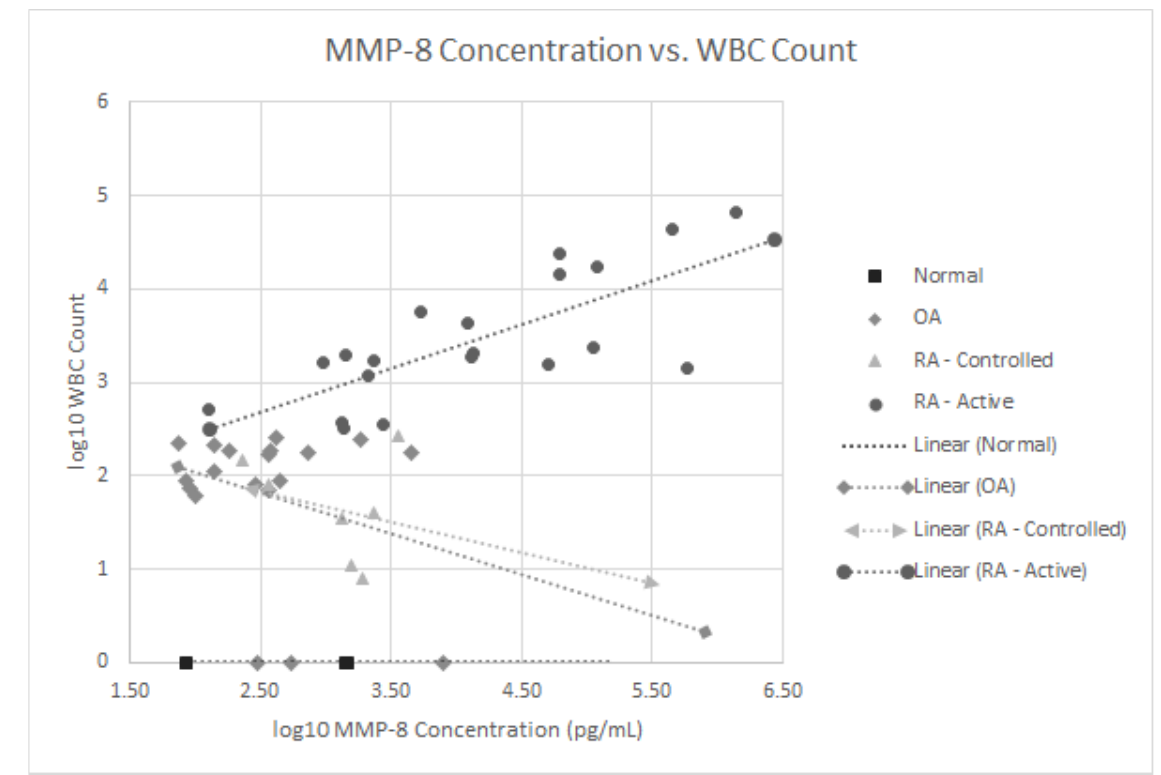
Figure 3. Log 10 plot of WBC counts vs. MMP-8 levels in normal subjects, patients with osteoarthritis, controlled rheumatoid arthritis and active rheumatoid arthritis.